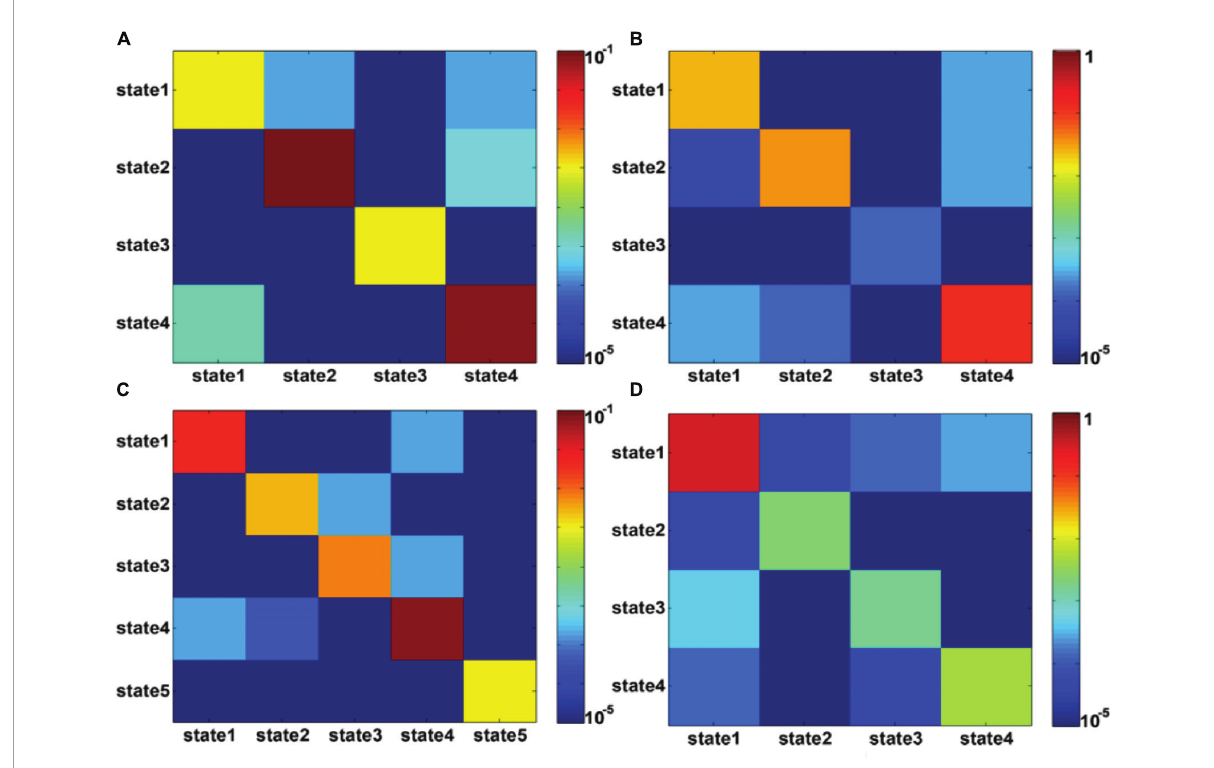
FIGURE4 (A,B) represent the transition probability among DFC states for presailors and backsailors, where the DFC states extracted from the DFCs of all seafarers before and after sailing. (C,D) represent the transition probability among DFC states for presailors and backsailors, respectively, where the DFC states extracted from the DFCs of seafarers before and after sailing, respectively. Note that transition probability is color-mapped on a